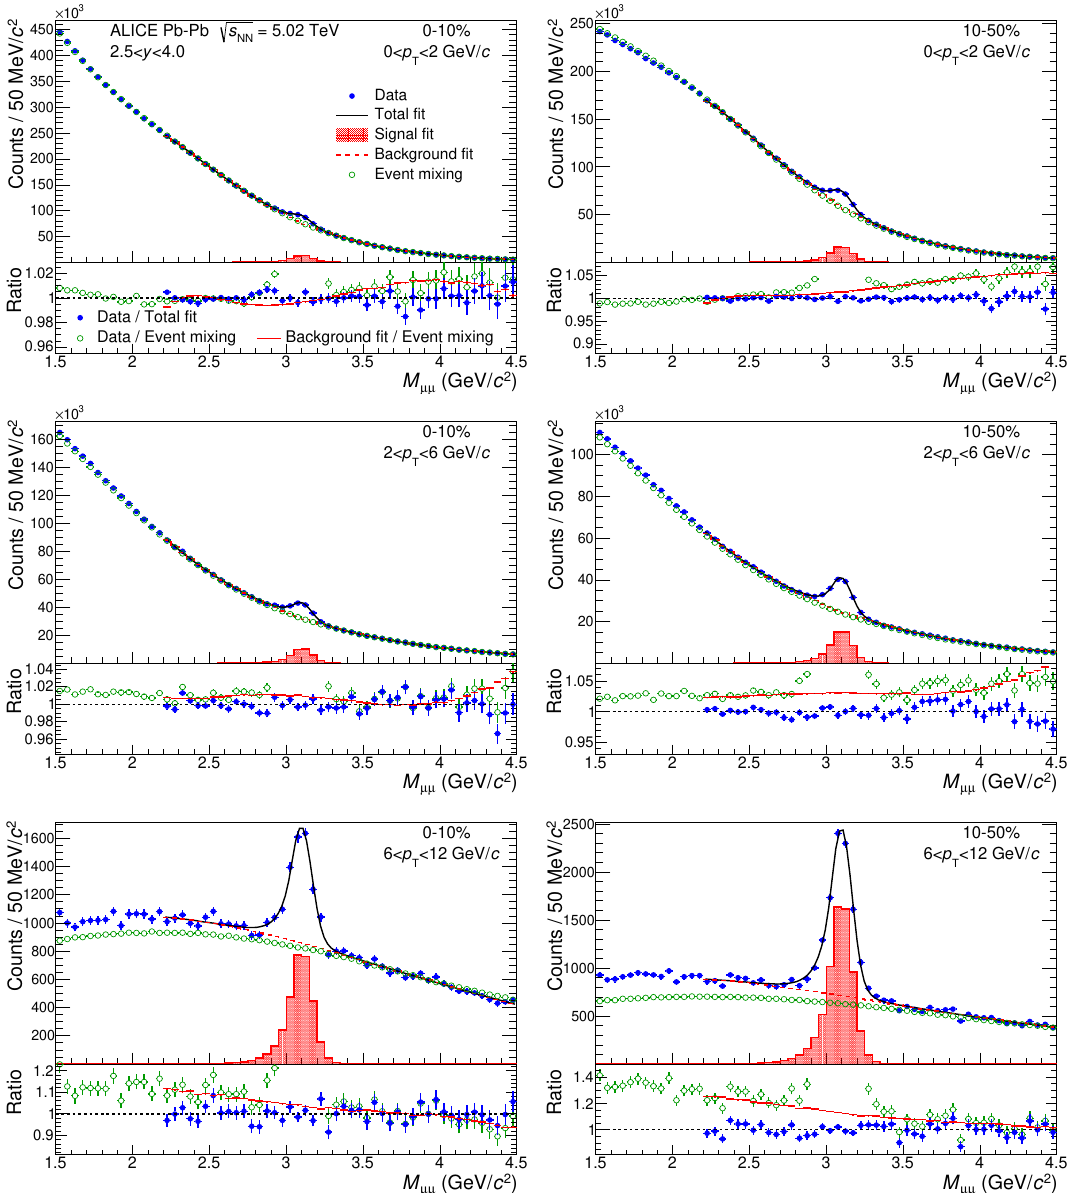
Figure 1 . (Color online) The M (cid:22)(cid:22) distribution in low (top panels), intermediate (middle panels) and high (bottom panels) p T intervals for central (left panels) and semi-central (right panels) collisions. The data are (cid:12)tted to a combination of an extended Crystal Ball (CB2) function for the signal and a Variable-Width Gaussian (VWG) function for the background. The distributions are compared to the ones obtained with the event-mixing technique (see text for details). Only statistical uncertainties are